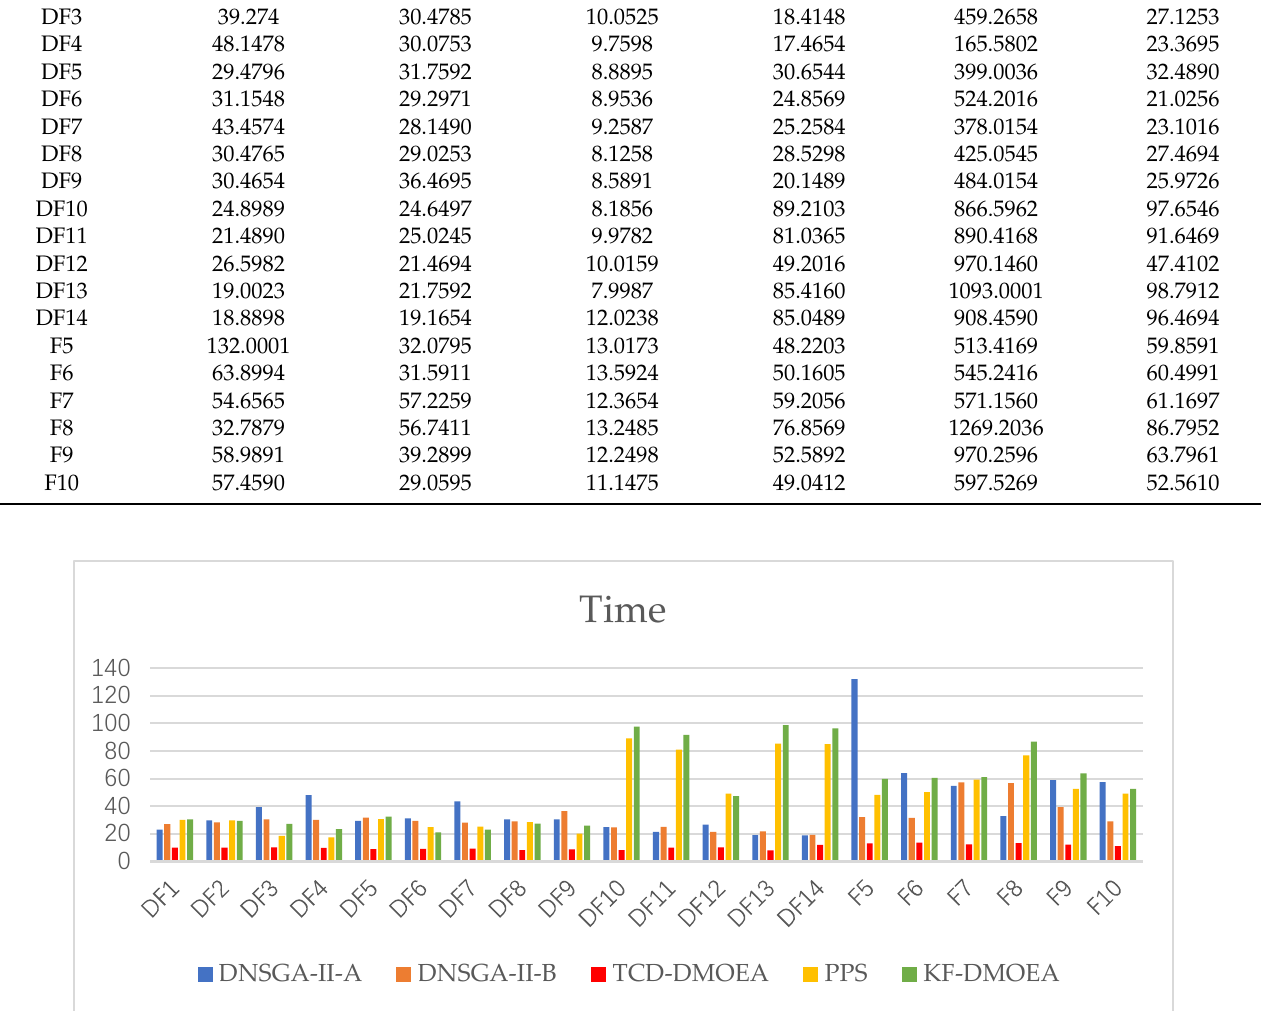
Table 4. The average running time (seconds) of the six algorithms under the S2 con fi guration.